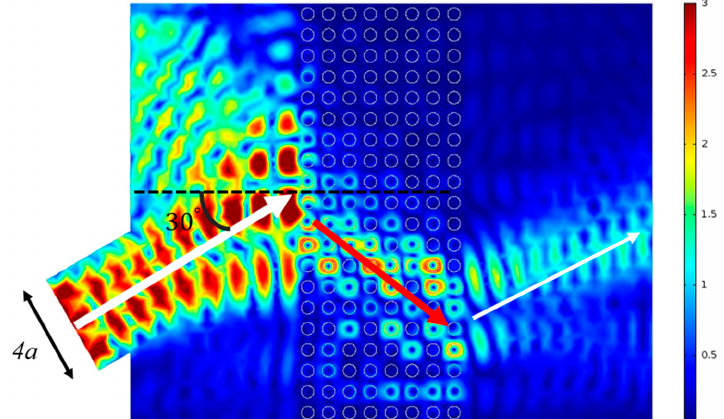
Figure 6. The simulation of wave propagation for negative refraction. A plane elastic wave of 500 Hz is incident from the left side of phononic crystal. The width of the wave and the incident angle are 4 a and 30 ◦ , respectively. The refraction angle is about − 45 ◦ and the refraction ratio is about − 0.707. The material on both sides of the structure is steel.